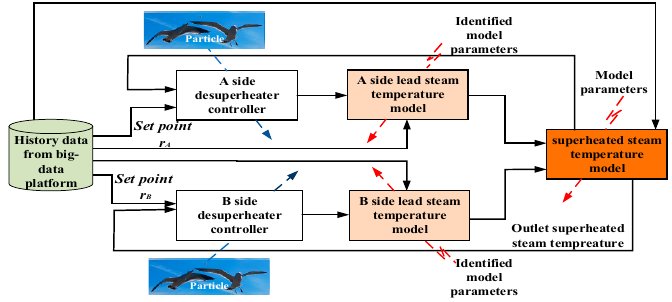
Figure 5. Schematic diagram of desuperheater control simulation system.